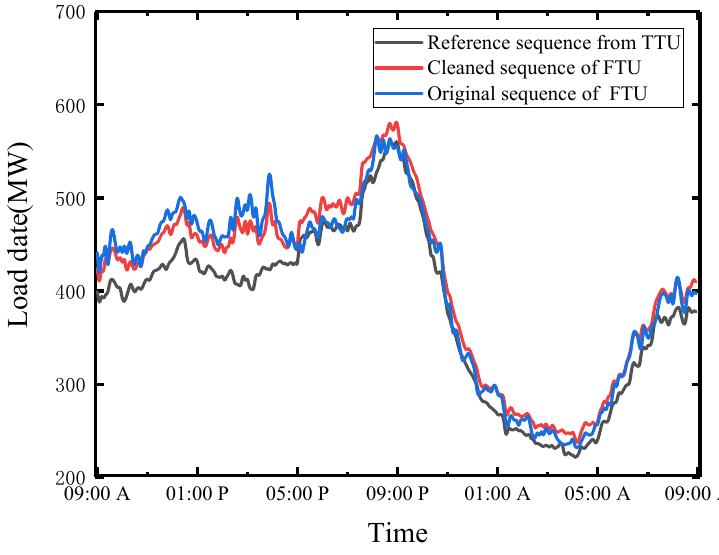
Figure 14. FTU-measured data curve after space–time combined filtering cleaning. The calculation formula of the spatial measurement deviation is 𝑣 (cid:3038) (cid:3030) (cid:3404) 𝑦 (cid:3038) (cid:3030) (cid:3398) 𝑥 (cid:3038) (cid:3030) , where 𝑥 (cid:3038)(cid:3030) represents the TTU measurement data value at time 𝑘 , and 𝑦 (cid:3038)(cid:3030) represents the FTU measurement data value at time 𝑘 . At the same time, the power flow relationship between FTU and TTU in Figure 7 shows that the spatial measurement deviation between FTU and TTU should theoretically be positive. The power system will be attacked by dirty data to varying degrees due to the influence of the actual site, thereby causing a large deviation in the measurement data of the measurement equipment. Thus, the spatial